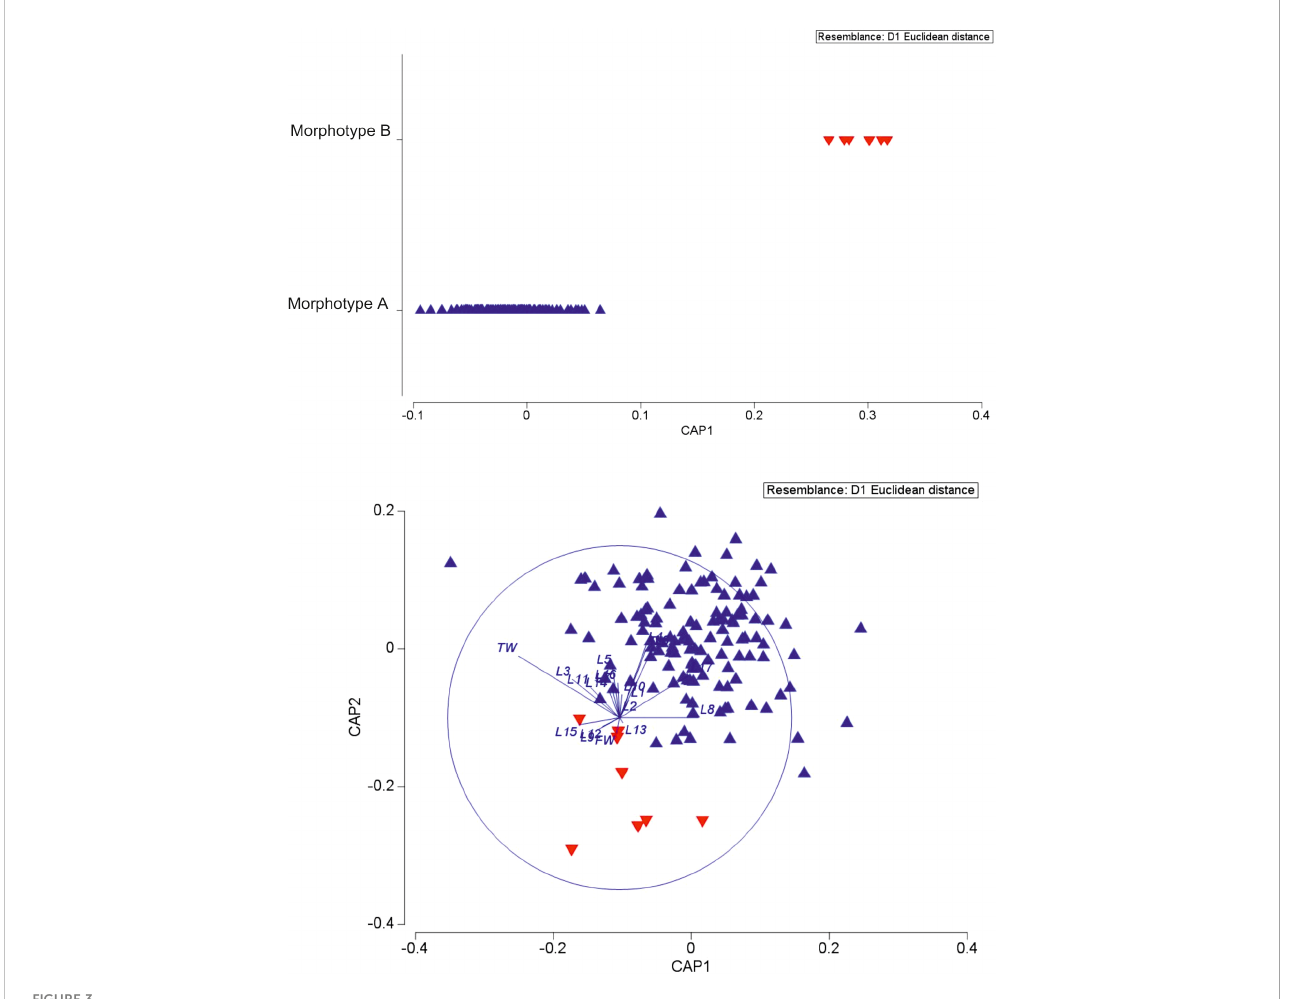
FIGURE 3 Canonical analysis of principal coordinates of biometric data of the two spatangids under